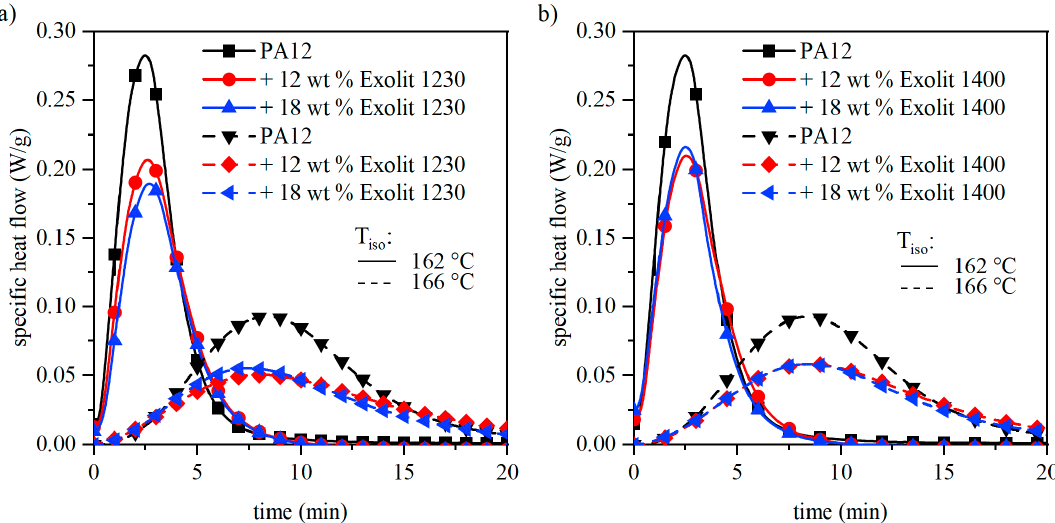
Figure 6. Isothermal DSC measurements of the polymer and composite powders for di ff erent flame retardant concentrations.